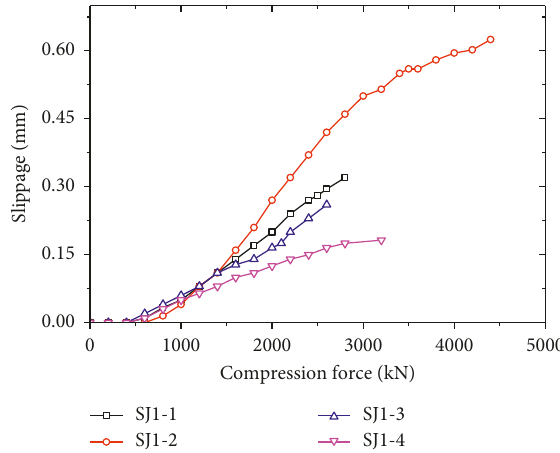
Figure 10: Slippage between the steel tube and concrete